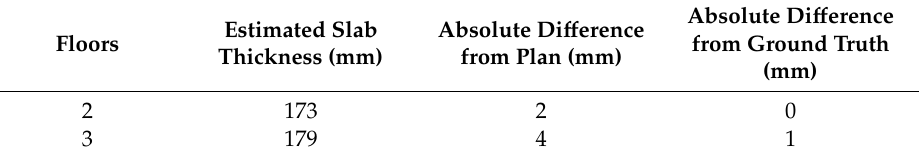
Table 6. Accuracy assessment of floor slab